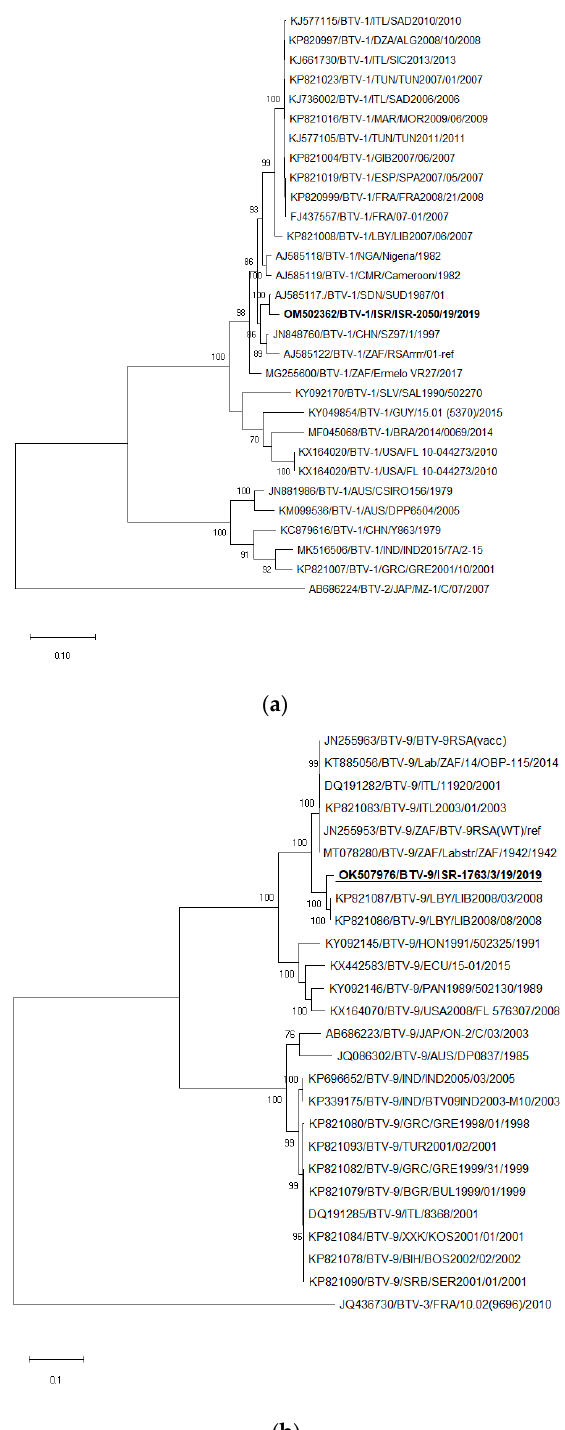
Figure 2. Phylogenetic tree of segment 2 of Israeli BTV-1 and BTV-9 strains isolated in 2019. ( a ) Phylogenetic tree of BTV-1 and global BTV-1 strains. BTV-2 was used as an outgroup. Israeli BTV-1 strain is shown in bold. ( b ) Phylogenetic tree of BTV-9 and global BTV-9 strains. BTV-3 was used as an outgroup. Israeli BTV-9 strain is shown in bold and is underlined. The phylogeny was inferred using the Maximum Likelihood method and Tamura – Nei model method. The percentage of replicate trees in which the associated taxa clustered together in the bootstrap test (1000 replicates) are shown next to the branches. Viruses were identified by accession number/serotype/location/isolate/year.